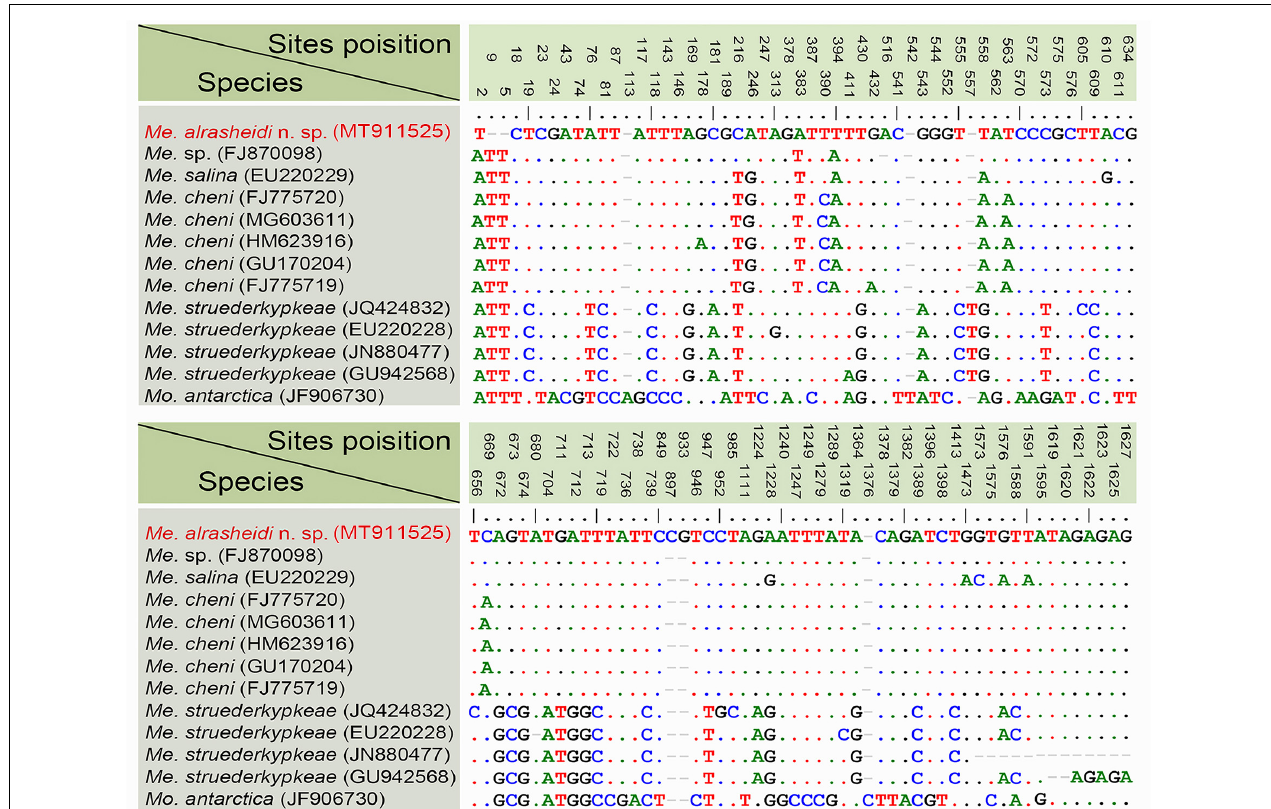
FIGURE 6 | Nucleotide differences among populations of Metaurostylopsis species and Monourostylopsis antarctica (Jung et al., 2011) n. comb., based on 18S rRNA gene sequences. The vertical numbers indicate the unmatched site positions. The new sequence is in red. Short lines (–) suggest the insertions and deletions. Solid dots represent matched